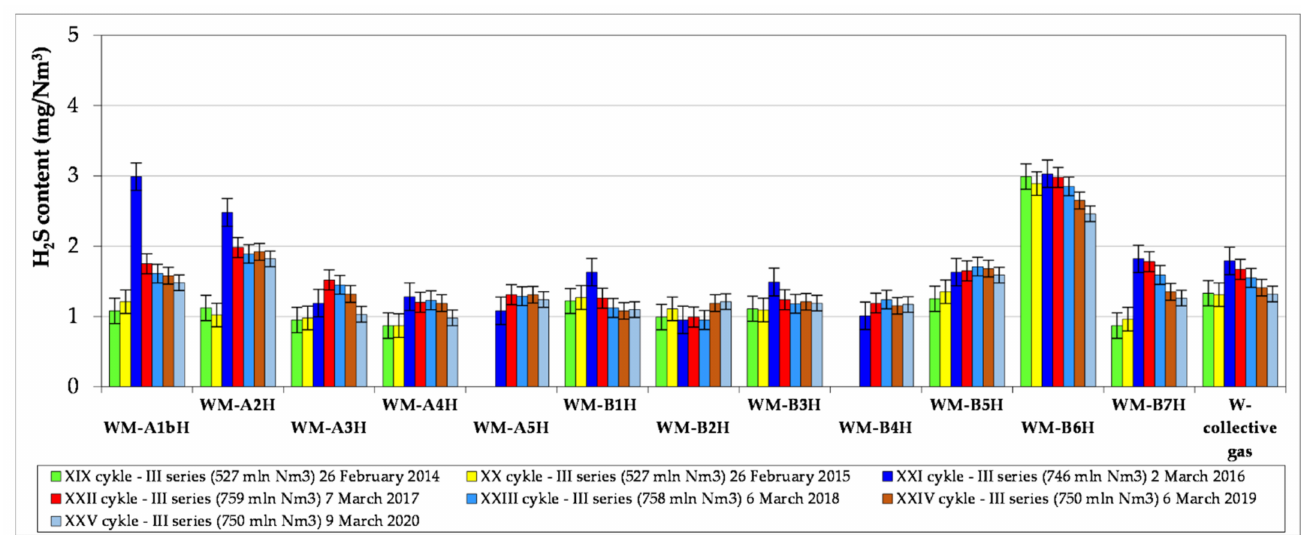
Figure 8. A comparison of the hydrogen sulphide content in the gas from the operational horizontal wells in the A and B clusters of the Wierzchowice Underground Gas Storage facility (series III), cycles XIX–XXIV.